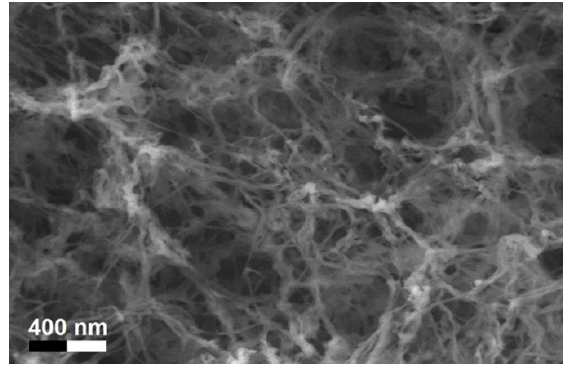
Figure 6. Inner structure of pure alginate aerogel produced via the diffusion method.